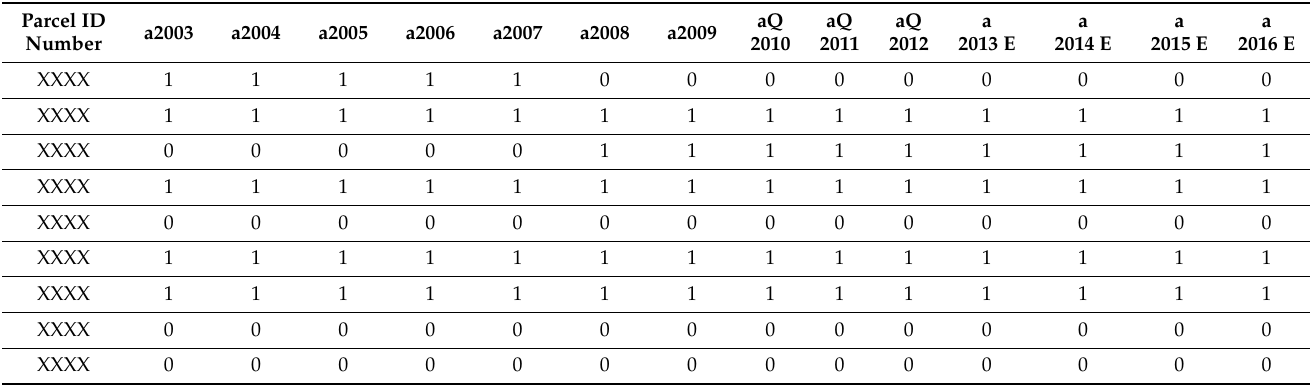
Table 1. Example illustrating the database structure having assigned each land parcel a unique ID (Parcel ID Number; all IDs have been changed for privacy reasons), a zero value (not claimed for) or a value of one (claimed for) for each of the years 2003 to